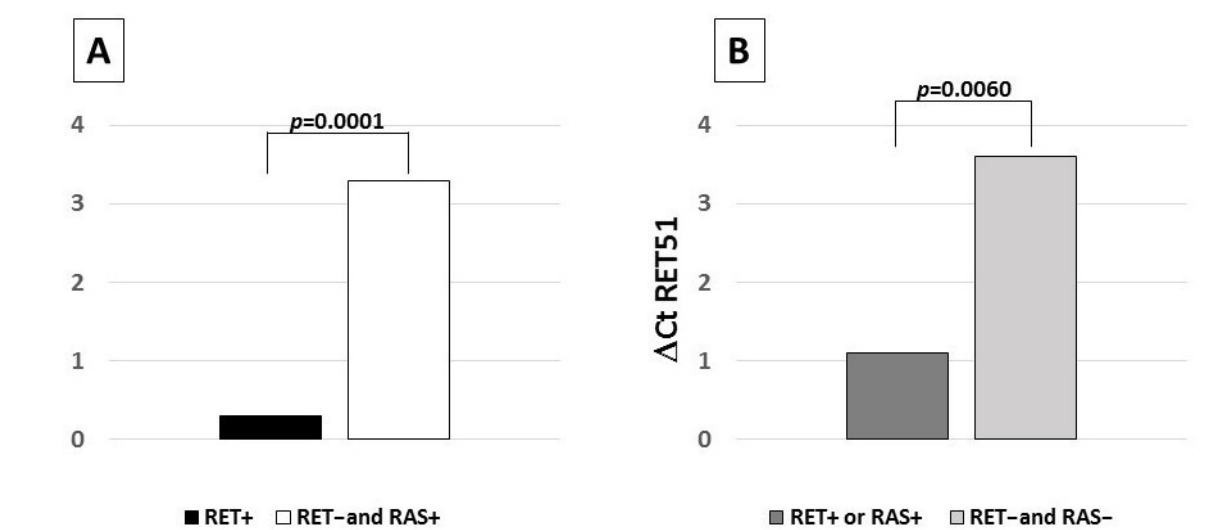
Figure 3. RET51 isoform expression levels according to the somatic mutation profile. A statistically significant higher expression level was observed in RET + cases than in RAS + cases and RET− and RAS− cases. Gene expression levels are reported as ΔCt (ΔCt = Ct RET – Ct G6PD ) where Ct is the threshold cycle for qRT- PCR. The lowest is the ΔCt value , and the highest is the mRNA expression level.